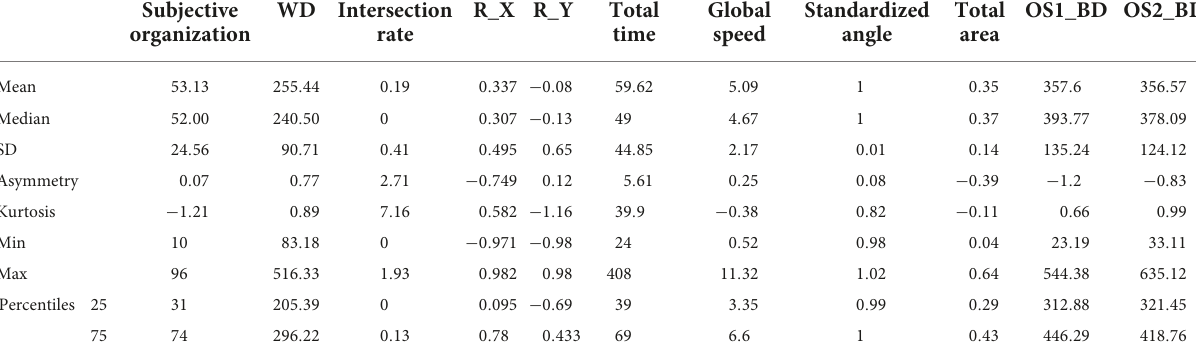
TABLE 1 Descriptive statistics for the indexes and the measure of subjective organization.